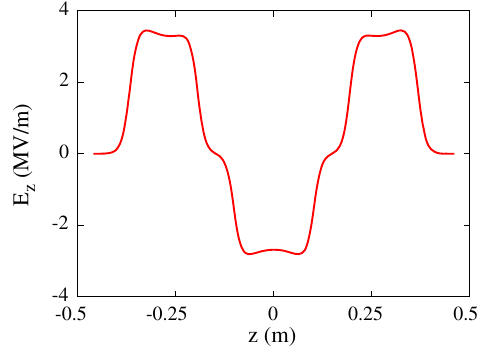
FIG. 6. The accelerating electric field along the beamline of the double-spoke SRF cavity.